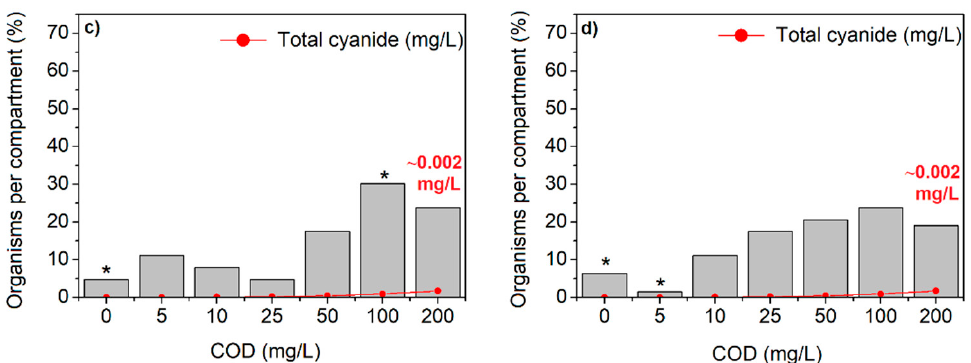
Figure 5. Relation of the distribution of organisms per compartment and the content of total cyanide for ( a ) dilutions of the untreated synthetic water after 4 h of exposition; ( b ) dilutions of the untreated synthetic water after 6 h of exposition; ( c ) dilutions of the treated synthetic water after 4 h of exposition; and ( d ) dilutions of the treated synthetic water after 6 h of exposition. The asterisk (*) indicates values that show significant and very significant statistical variations with respect to the expected number of organisms. Data of organisms per compartment were pooled from 3 replicates; therefore, the standard deviation is not presented.